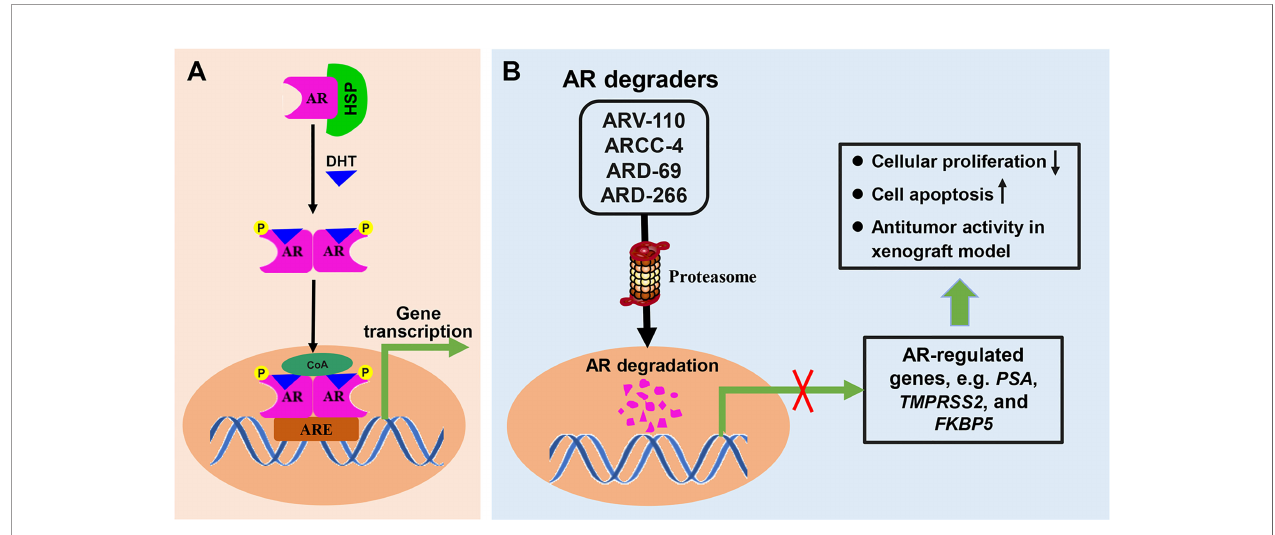
FIGURE 5 | The mechanisms involved in AR signal pathway and PROTACs targeting AR. (A) Dihydrotestosterone (DHT) binds to inactivated AR, and cause the dissociation of heat shock protein (HSP) from AR-HSP complex. DHT-bound AR translocate to the nucleus after suffer phosphorylation and dimerization, then interacts with the androgen response element (ARE) and control target gene transcription. (B) PROTAC AR degraders can induce proteasome-mediated degradation of AR protein, and effectively suppress the mRNA levels of AR-regulated genes, which resulted in cellular proliferation inhibition, induction of cell apoptosis, and antitumor activity in xenograft